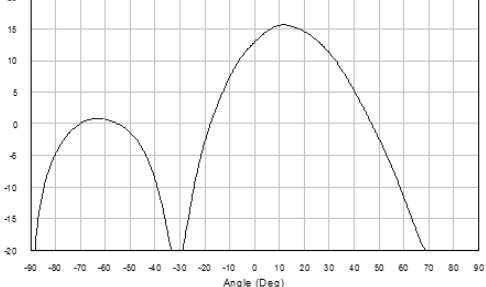
Fig. 4. Radiation pattern of small array when the beam is deflected down (a) and up (b) in the elevation plane